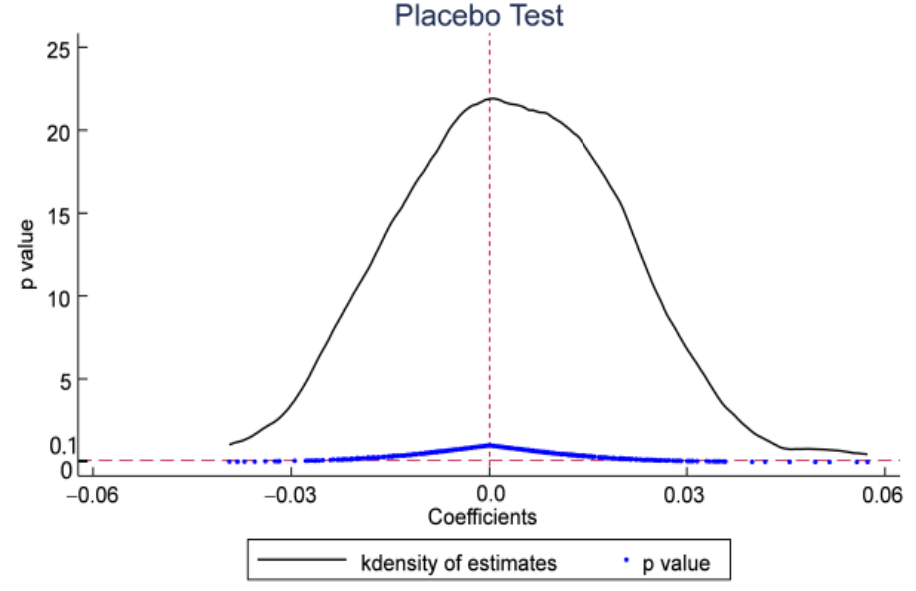
Figure 3. Placebo